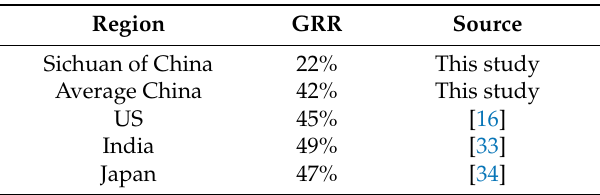
Table 12. Results of GHG emissions GRR for NG pathway compared with the conventional coal and public grid combined pathway in different